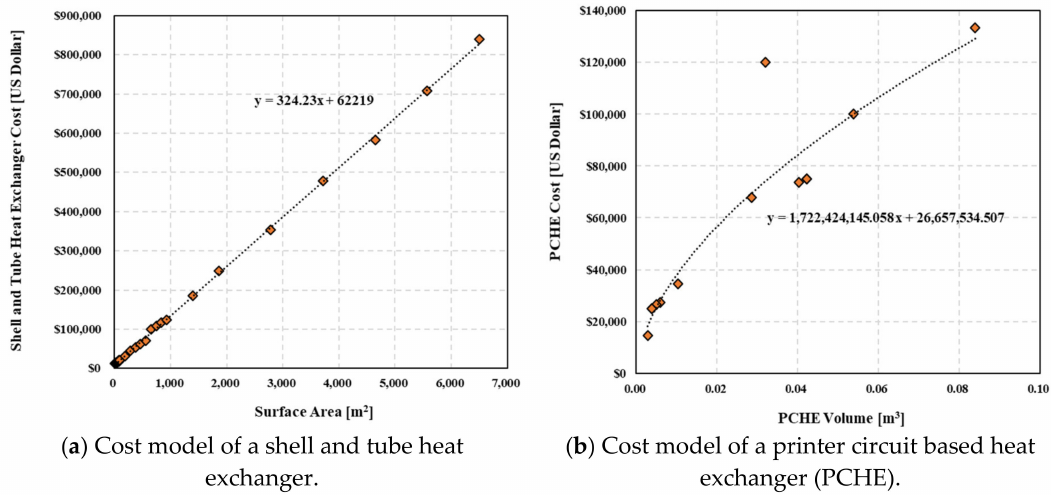
Figure 3. Heat exchanger cost